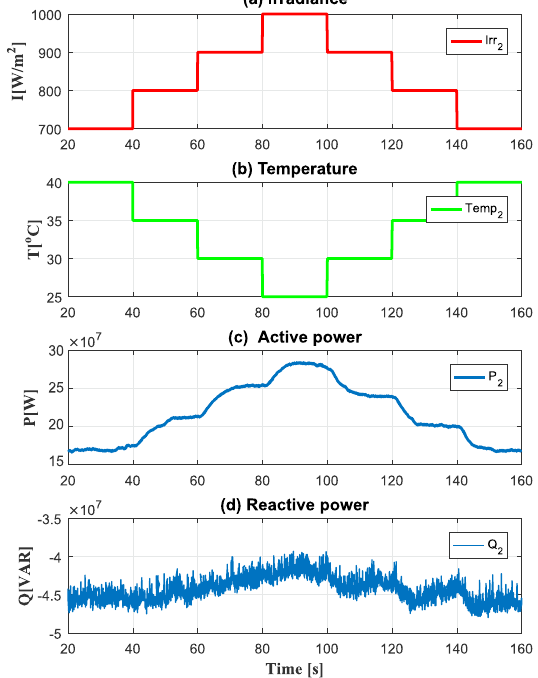
Figure 10. PV Array 2 variables: ( a ) Irradiance, ( b ) temperature, ( c ) active power, and ( d ) reactive power.